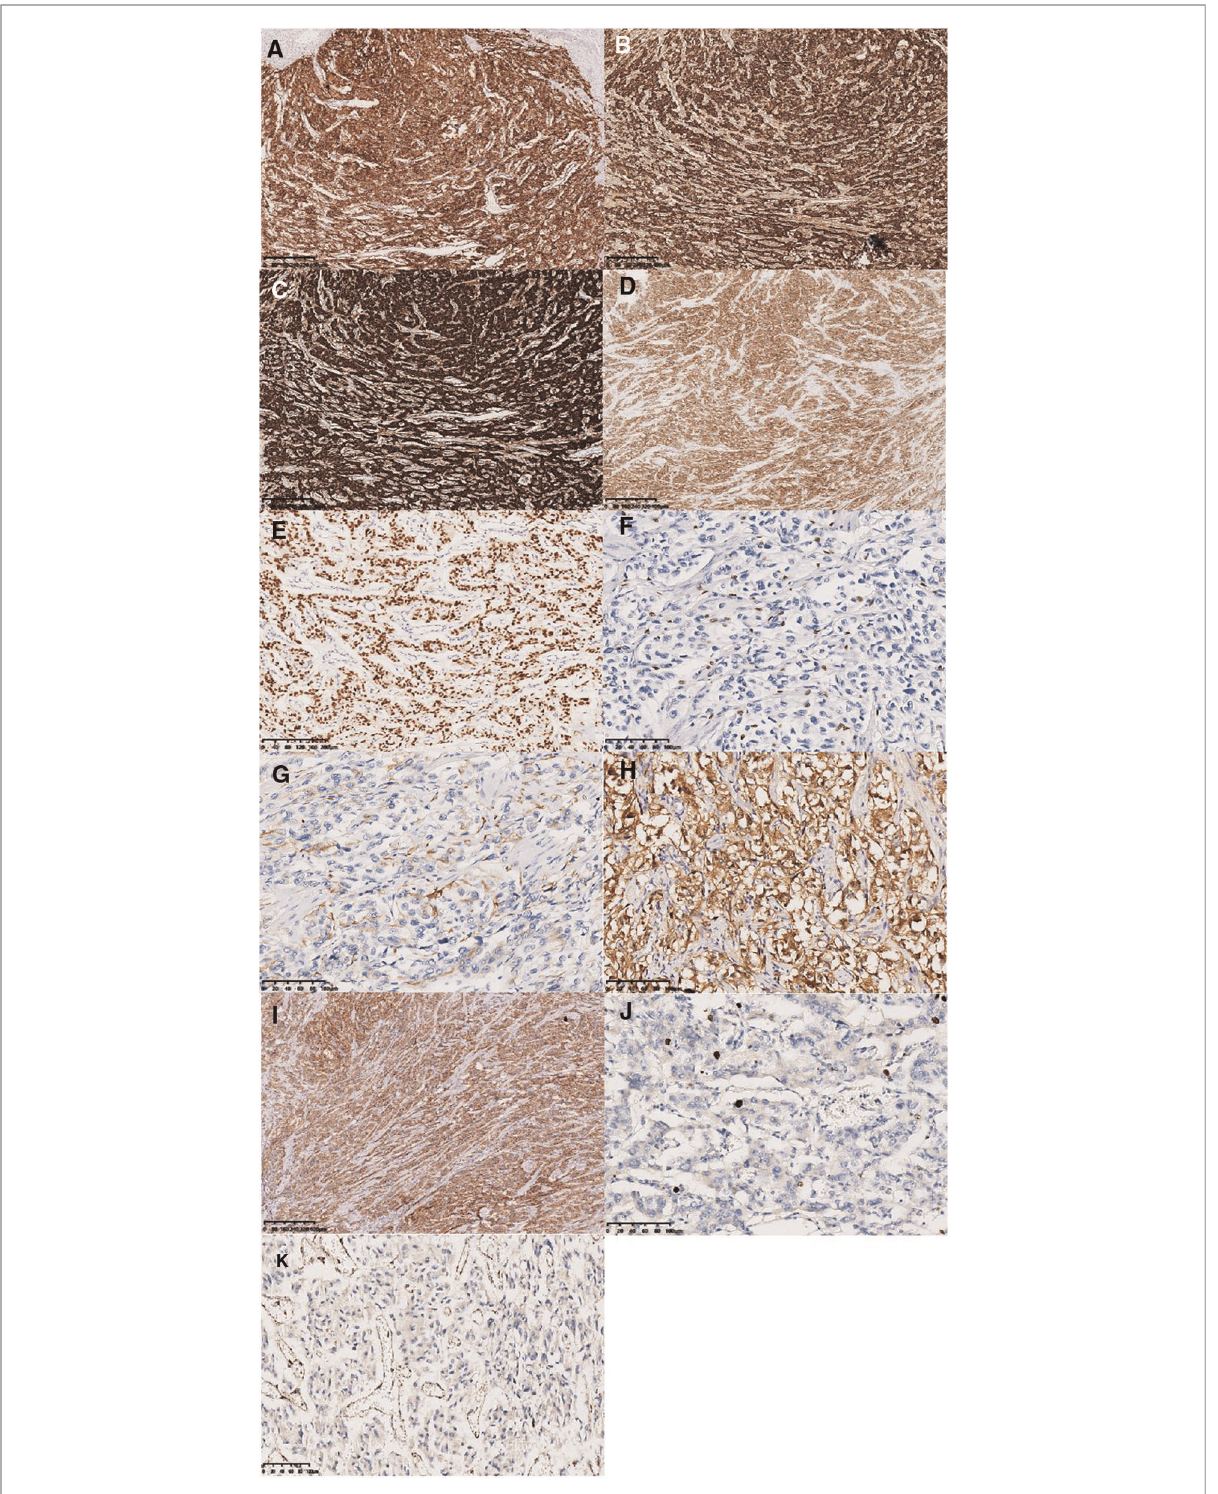
FIGURE 2 Immunohistochemical staining results. Neuroendocrine markers: CD56, ChrA, Syno, and NSE were diffusely and strongly positively expressed ( A , ×40; B , ×40; C , ×40; D , ×40). GATA3 was diffuse nucleus positive ( E , ×100). The sustentacular cells were highlighted by SOX10, GFAP, and S-100 immuno-stain ( F , ×200; G , ×200; H , ×200). MelanA showed diffuse moderate expression ( I , ×40). The Ki-67 labeling index was approximately 5% ( J , ×200). SDHB showed negative expression ( K ,